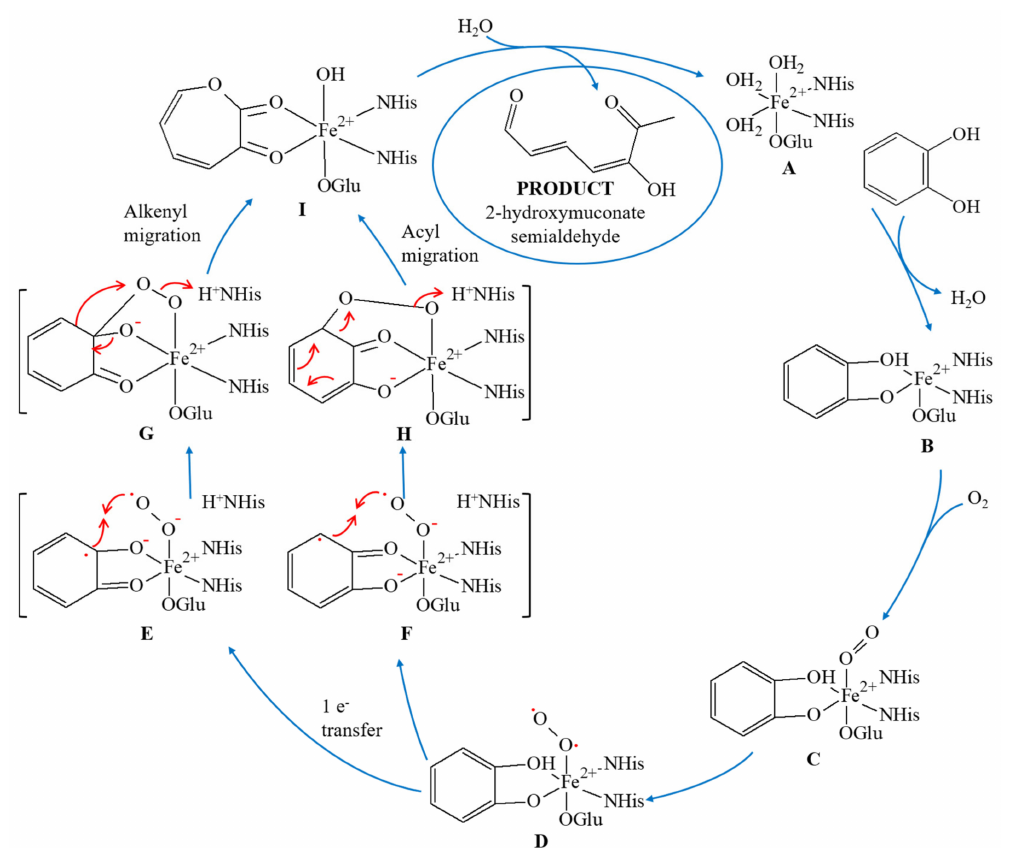
Figure 5. Mechanism of catechol conversion by 2,3-CD extradiol